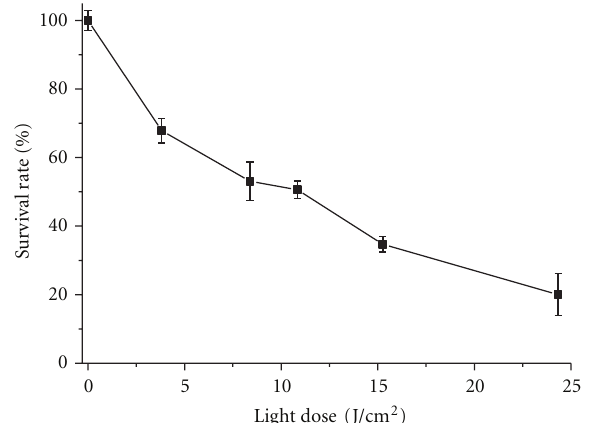
Figure 5: The cell survival rate of CNE1 cells after 5-ALA medicated